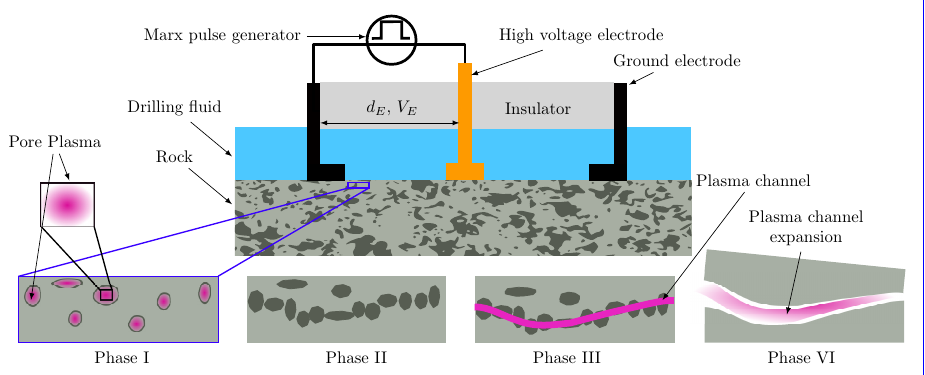
Figure 1. Schematic showing the PPGD concept and arrangement, i.e., the electrodes, the drilling fluid, and the rock. Phase I and Phase II show the plasma formation in the pores and the resultant pore space expansion [23]. Phases III and IV show the plasma channel formation, expansion, and rock damage